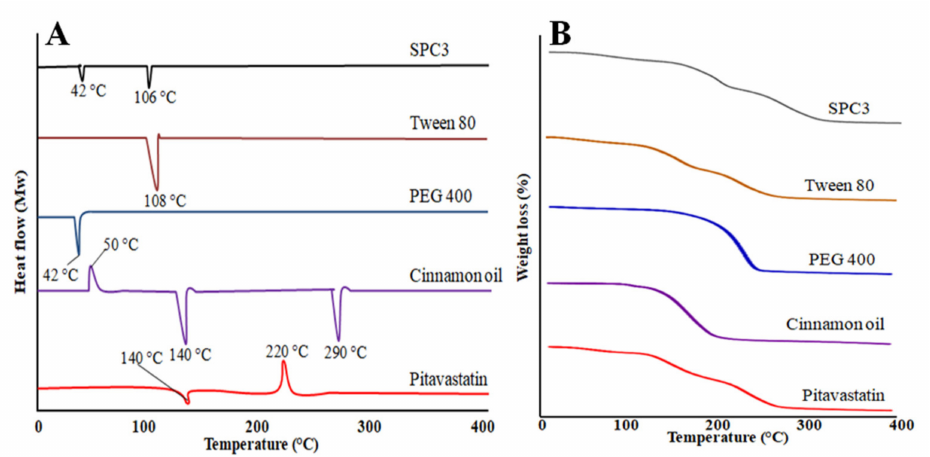
Figure 4. DSC thermograms ( A ) and TGA ( B ) curves of pitavastatin, cinnamon oil, PEG 400, Tween 80, and the SPC3